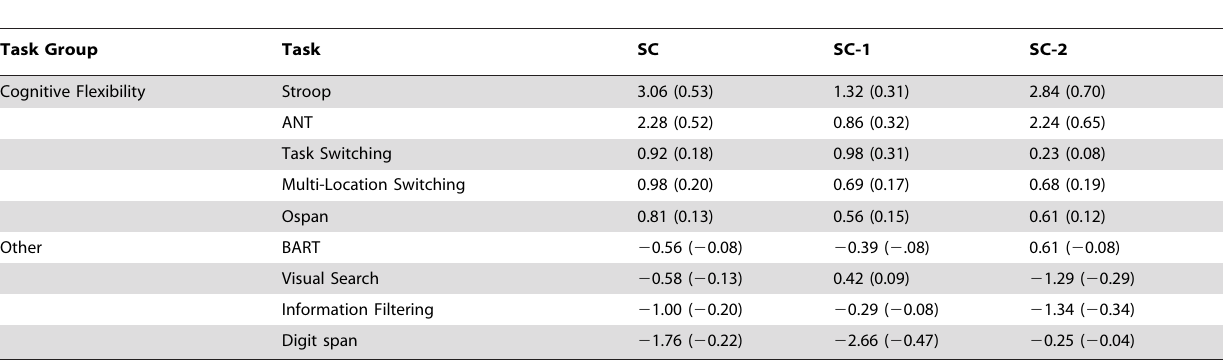
Table 1. The t -values, which were the basis for calculating the meta-analytic Bayes factors, contrasting post-test minus pre-test scores for SC groups versus the control (Sims) group.